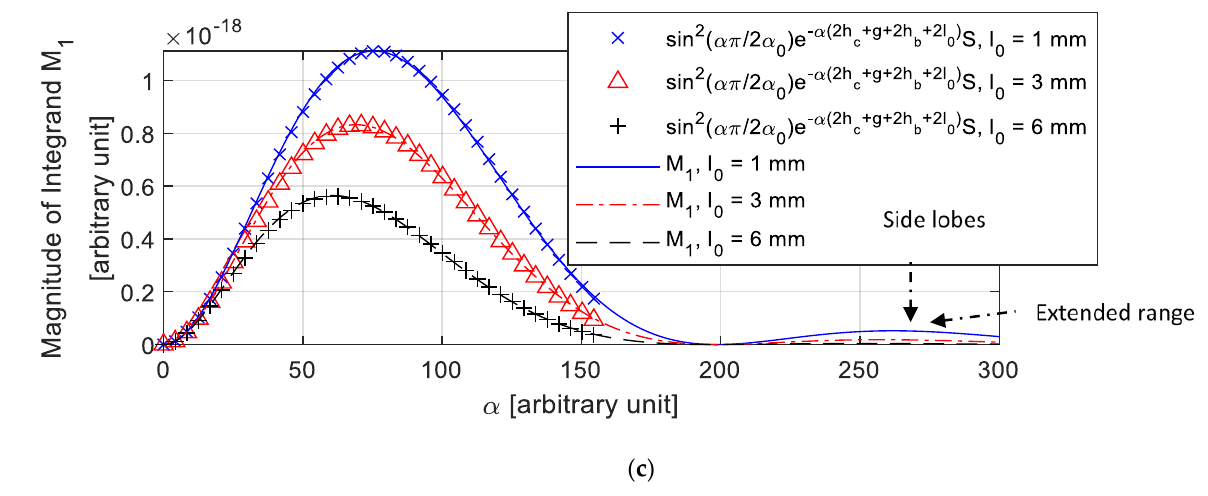
Figure 2. ( a ) Phase of the integrand in (1) and (2). ( b ) Matched function for the magnitude of the integrand in (2). ( c ) Side lobes occur in the magnitude of the integrand in (1); the range of α extends.